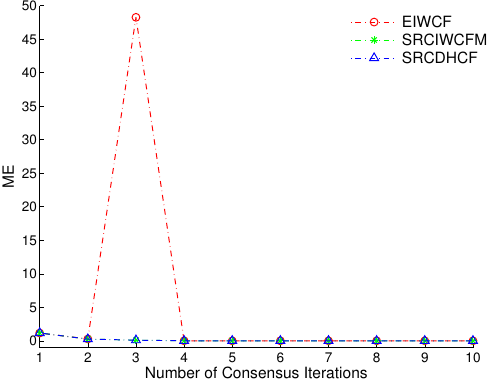
Figure 2. The comparison of mean errors (ME) of square-root cubature information weighted consensus filter with Metropolis weights (SRCIWCFM), square-root cubature dynamic hybrid consensus filter (SRCDHCF) and the original EIWCF for 20 Monte Carlo